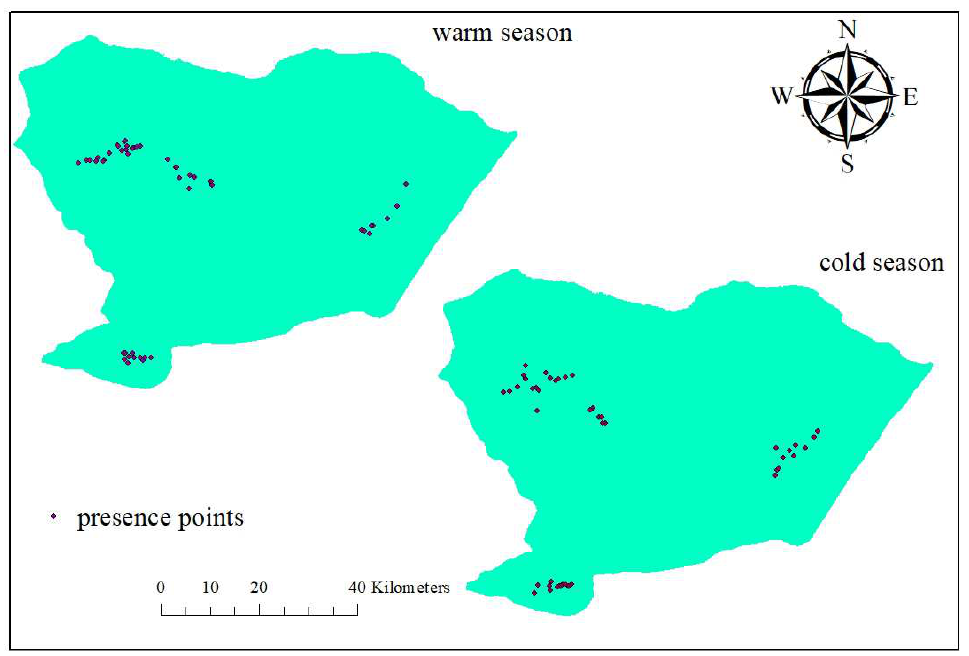
F IGURE 2. Presence records of Wild Goat in Kavir National